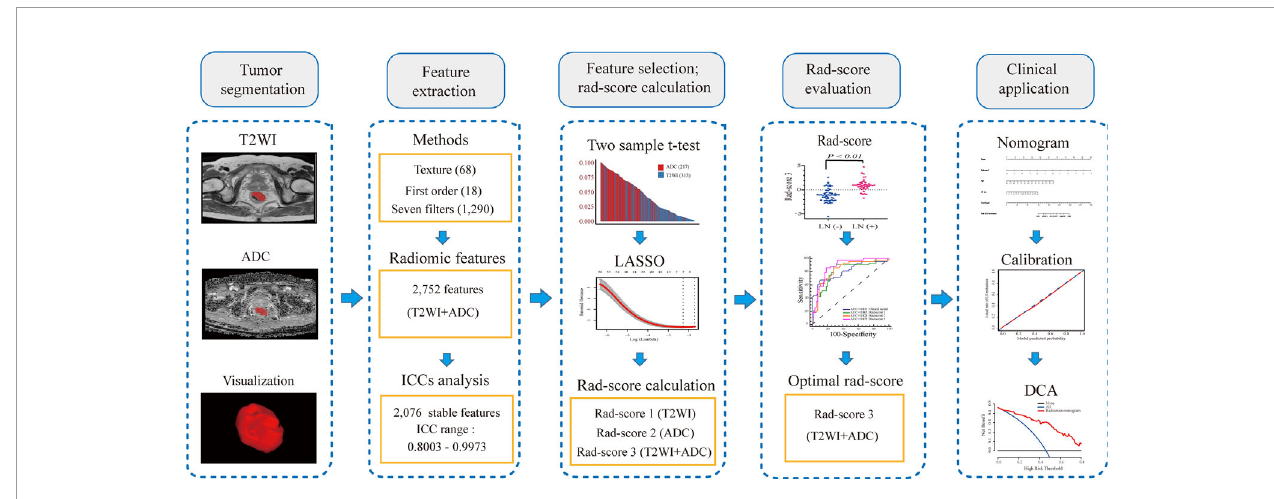
FIGURE 1 | The framework for the radiomics work fl